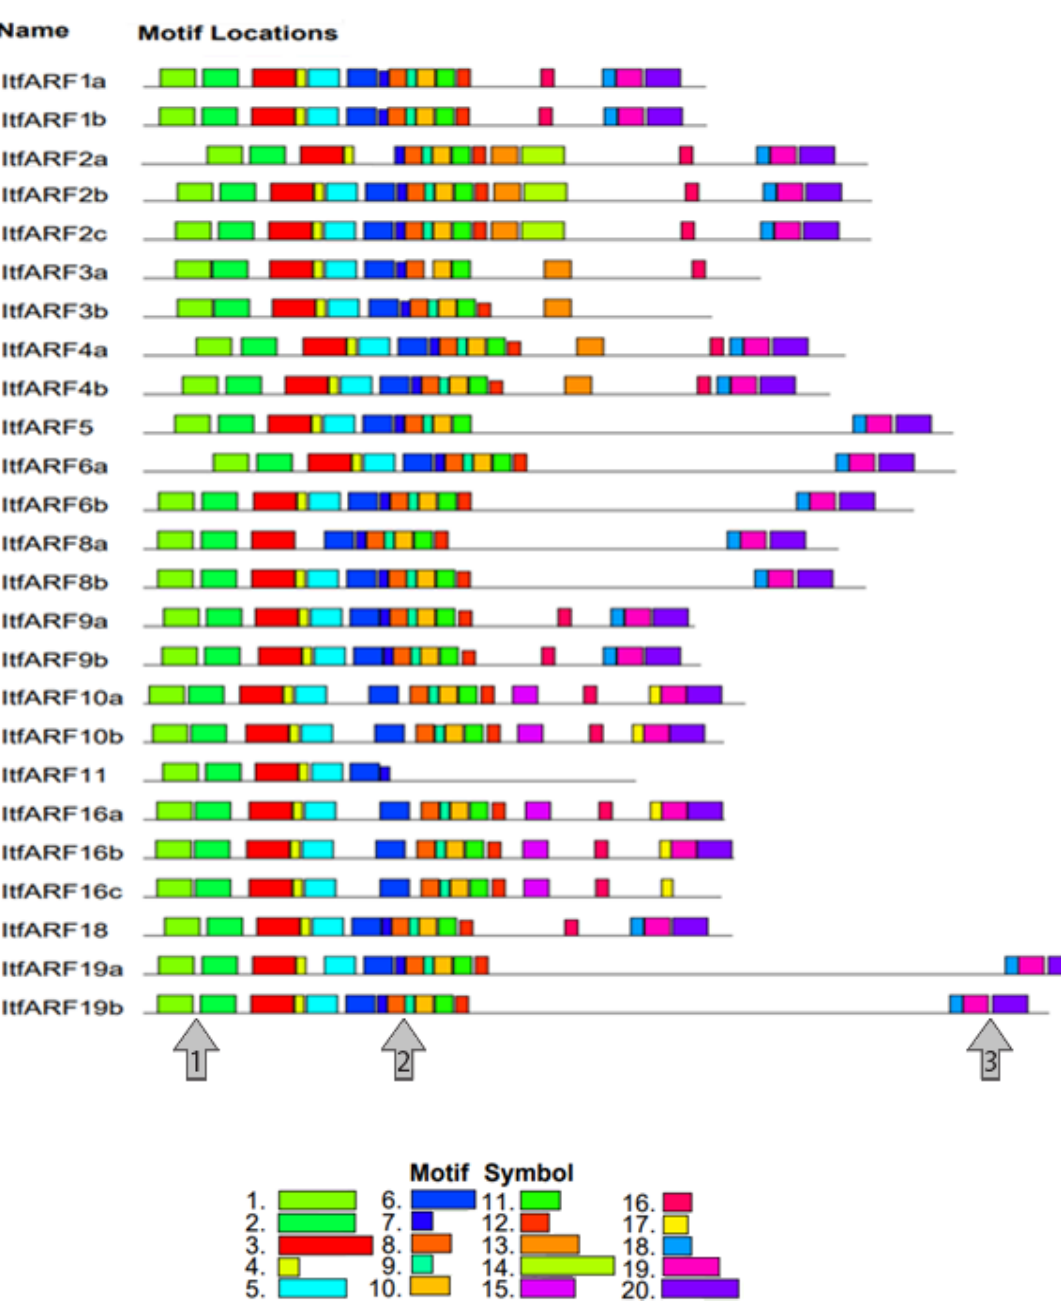
Figure 3. ItfARF proteins with twenty different identified conserved motifs through the MEME search tool. The motifs are numbered and represented by the different colors in Motif Symbol. Arrow 1 points to the DBD domain, Arrow 2 points to the ARF domain, and Arrow 3 points to the CTD domain.